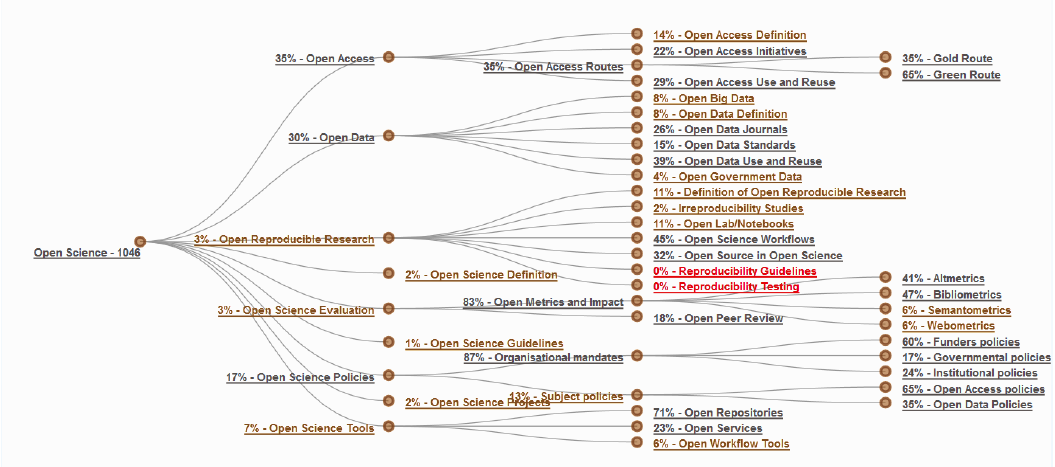
Figure 2. Open science taxonomy showing the distribution of